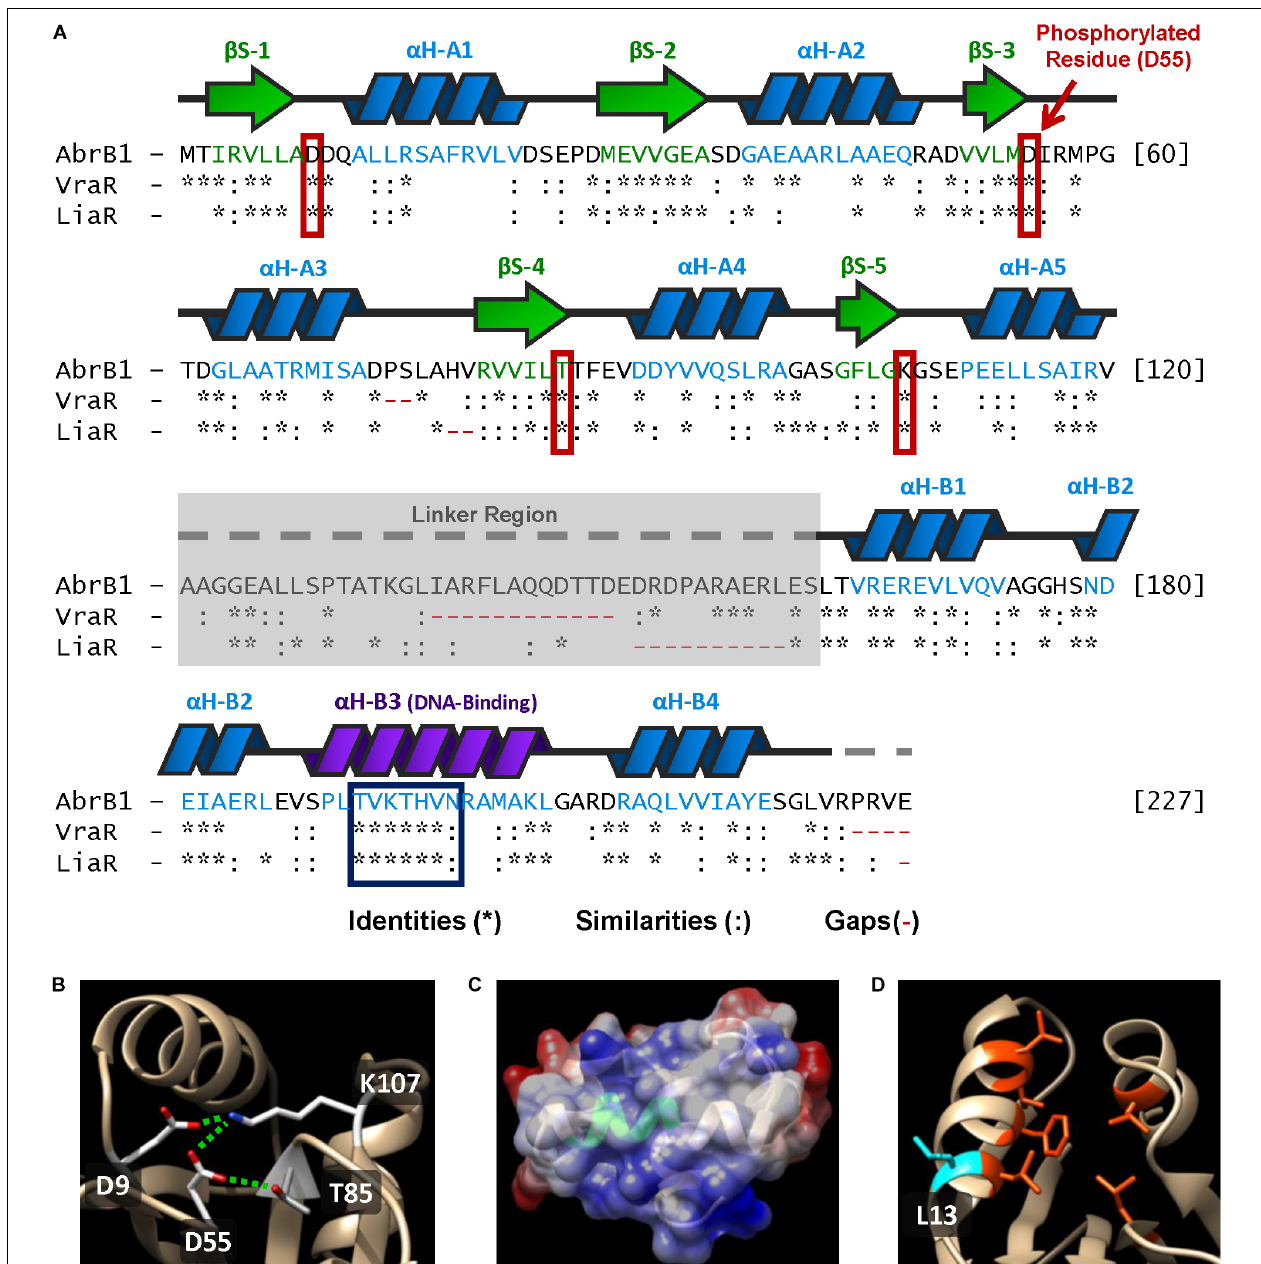
FIGURE 5 | Structural features of AbrB1 and its comparison with VraR and LiaR. (A) Sequence of the RR AbrB1. Secondary structures are shown above the amino acid sequence (beta-strands in green, and alpha-helices in blue). Comparison with VraR from S. aureus and LiaR from E. faecium is shown below the AbrB1 sequence; identities (*), similarities (:), and gaps (-) are indicated (pairwise alignment was performed in EMBOSS Needle applying a BLOSUM62 substitution matrix). Active site residues are squared in red, while conserved DNA-recognition site is squared in blue. (B) Phosphorylation site in AbrB1 structural model: D55 (phosphorylated residue), D9, K107, and T85. Interactions between residues (inactive form) are shown as dashed green lines. (C) DNA-binding helix in AbrB1 structural model. Conserved recognition site is shown in green. Electrostatic surface is represented (positive charge as blue, and negative charge as red). (D) Hydrophobic “pocket” in REC domain for the dimerization process. The residues that conform this “pocket” are shown in orange (Leu14, Phe18, Leu 21, Val22, Leu84, and Leu114); protuberant L13 (which interacts with the “pocket” of the other protomer) is shown in